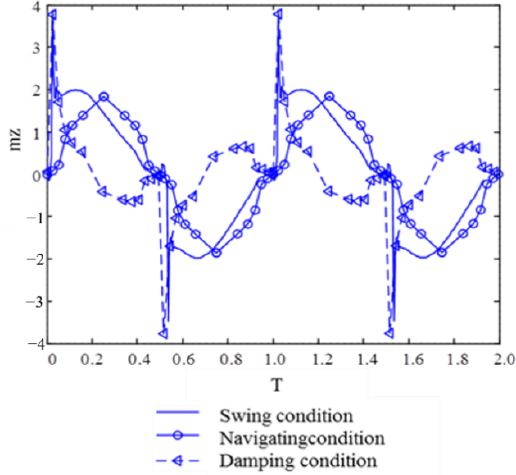
Figure 17. Curves of lift characteristic.